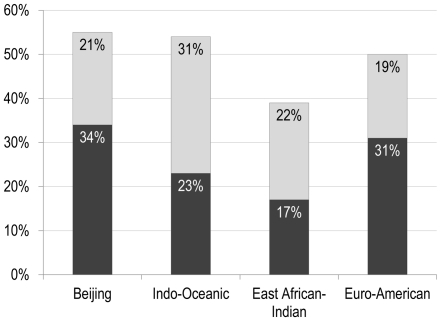
Estimated proportion of recent versus remote tuberculosis infection among derivation cohort contacts.A comparison between close contacts of active pulmonary TB patients within each MTB lineage group. Light coloured bars: proportion estimated to have remote TB infection based on the calculated probability of latent TB at the time of immigration to Canada (see methods for details). Dark coloured bars: remaining TST positive (out of total) assumed to have recent TB infection (i.e. equivalent to TST conversion). Abbreviations: TB = tuberculosis.